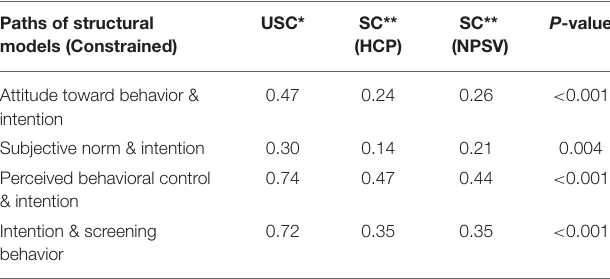
TABLE 4 | Path coefficients of the constrained multi-group